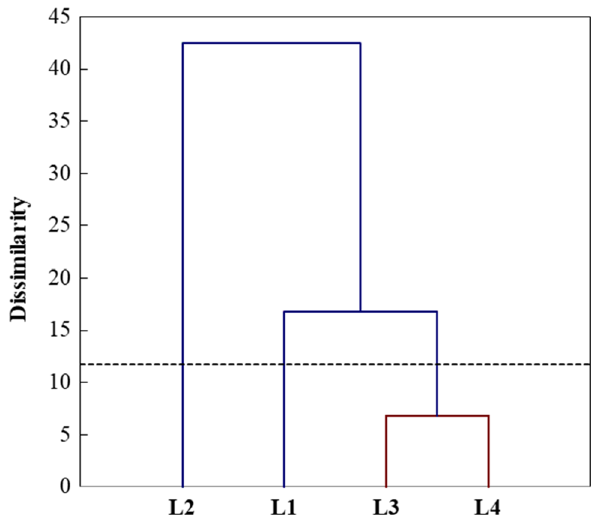
Fig. 2 Dendrogram of cluster analysis results for the four water sam- pling